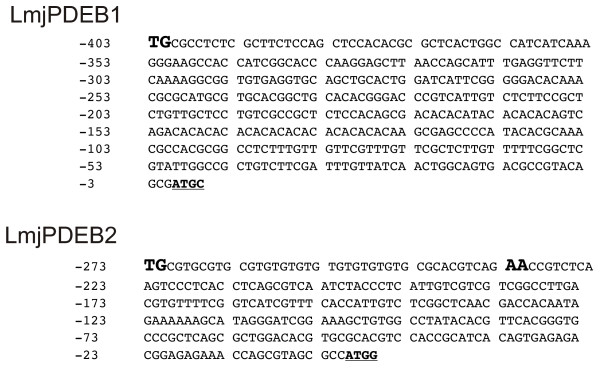
5'-UTR sequences of LmjPDEB1 and LmjPDEB2. Larger, bold letter indicate the various splice acceptor sites. Bold, underlined letters symbolize the start of the open reading frames.